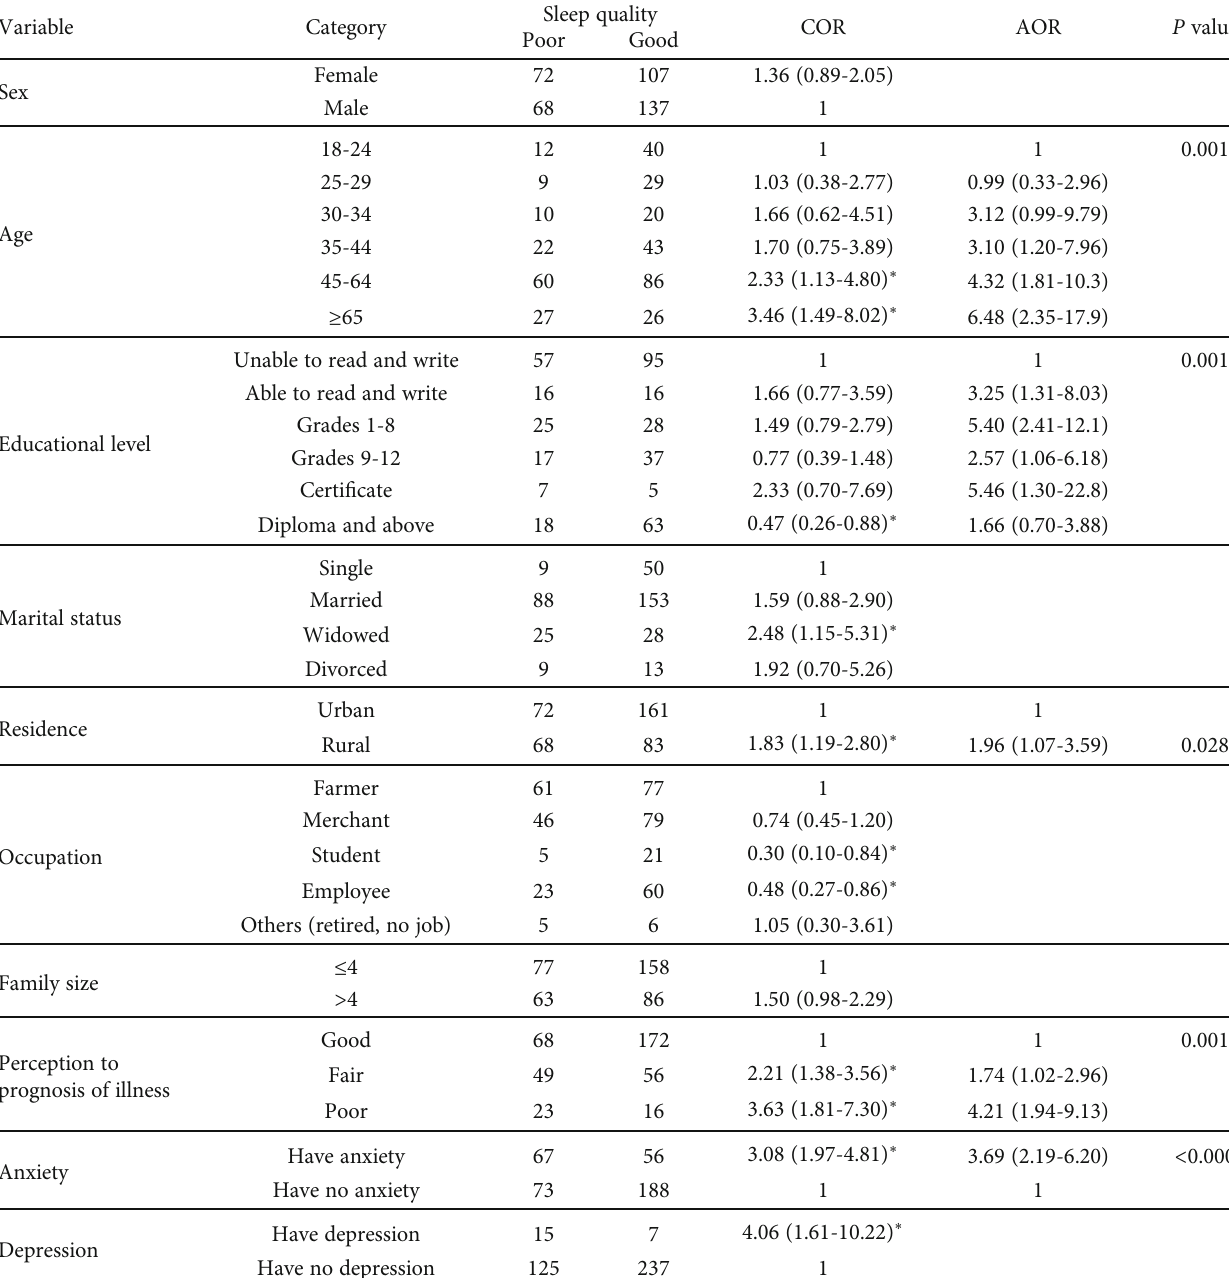
Table 4: Bivariable and multivariable logistic regression output on the association of sleep quality and factors, 2018 ( N = 384 ).